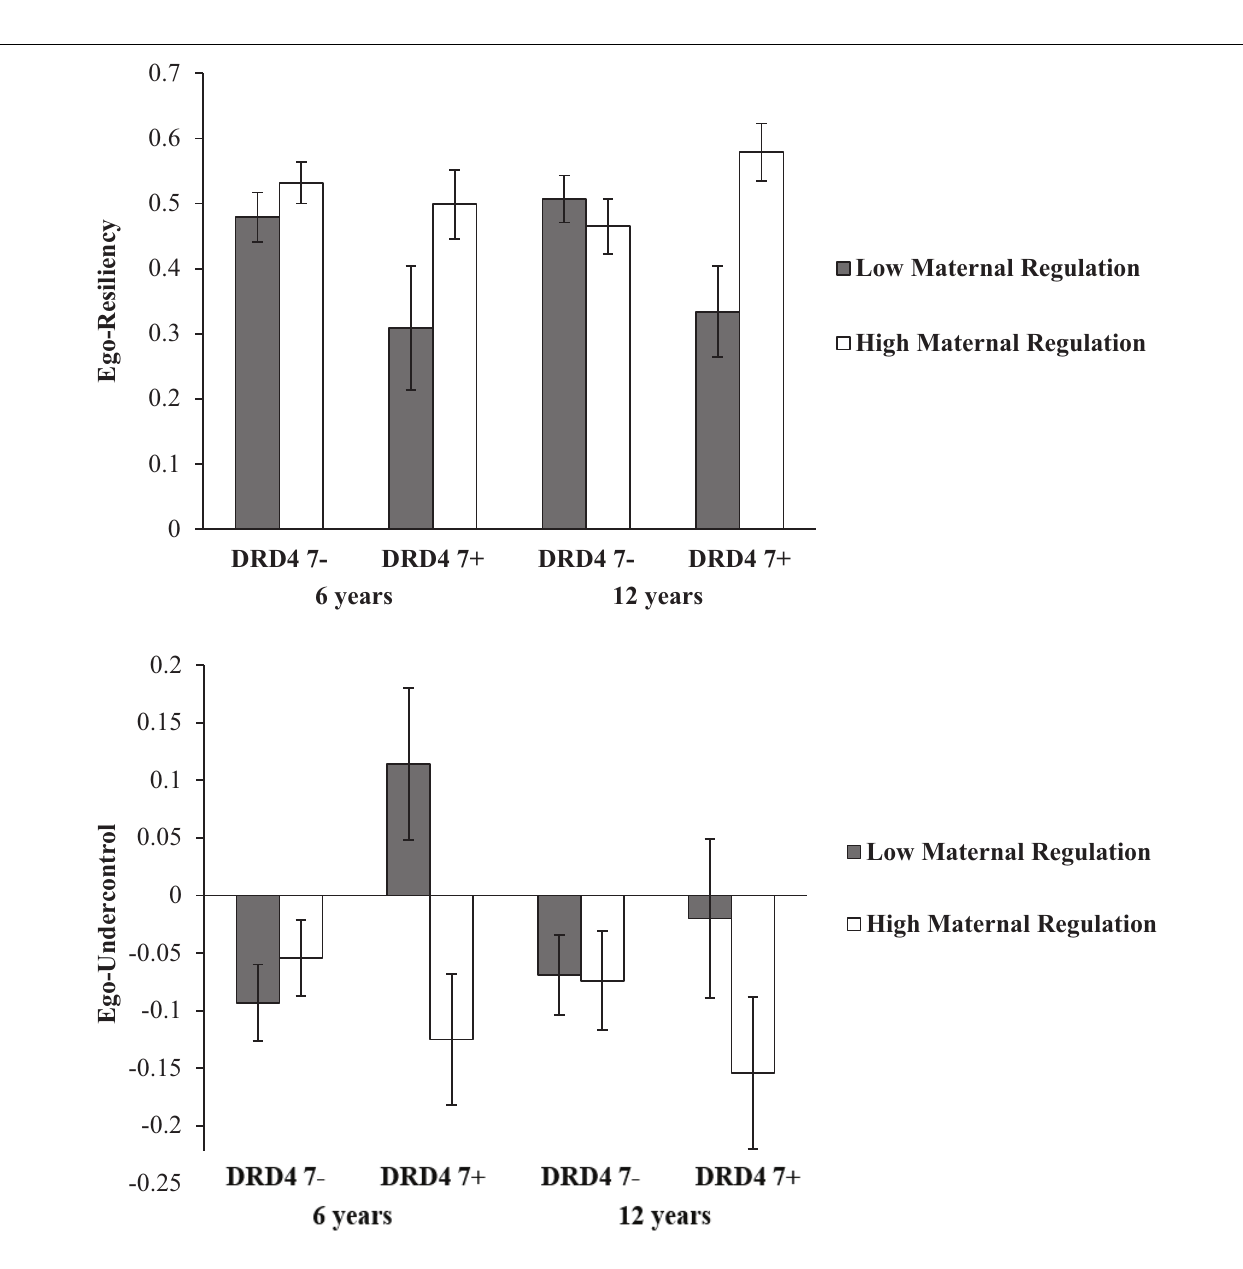
questionnaire revealed a significant multivariate interaction effect between DRD4 and maternal regulation quality ( F (4,83) = 2.71, p = 0.036, η 2 = 0.117). Univariate follow-up analyses showed a significant interaction effect for social competence ( F (1,85) = 9.97, p = 0.002, η 2 = 0.105) and a statistical trend of the interaction for inattentiveness/hyperactivity ( F (1,85) = 3.01, p = 0.087, η 2 = 0.034), and oppositional- aggression ( F (1,85) = 3.72, p = 0.057, η 2 = 0.042). Post hoc comparisons of the problem behaviors of children of mothers with low or high maternal regulation quality, conducted